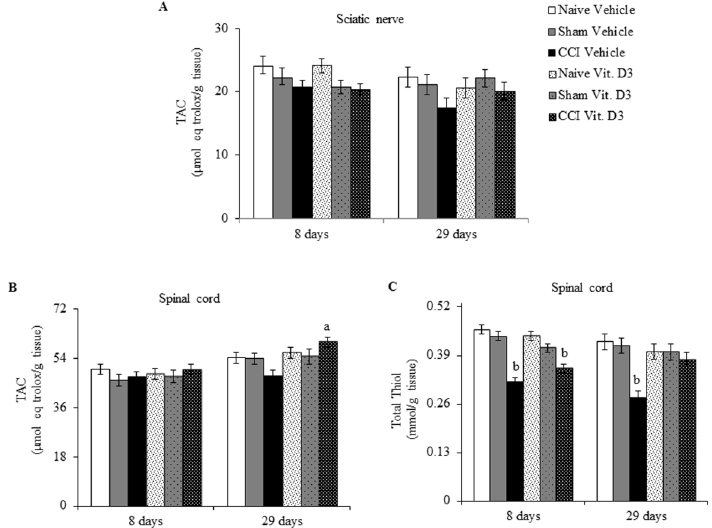
Figure 4. Total antioxidant capacity (TAC) ( A and B ) and total thiol content ( C ) in injured sciatic nerve ( A ) and spinal cord ( B and C ) of rats treated with vitamin D 3 (Vit. D3) (500 IU/kg per day) or vehicle for 7 or 28 days after chronic constriction injury (CCI). Rats were euthanized at 8 and 29 days post-surgery. Data are reported as means ± SE (n=6/group). a P o 0.05 compared to vehicle-treated CCI rats at the same measurement time; b P o 0.05 compared to naive and sham groups (two-way ANOVA followed by Tukey ’ s post hoc test). For Sham rats, all surgical procedures involved in the CCI were used except the